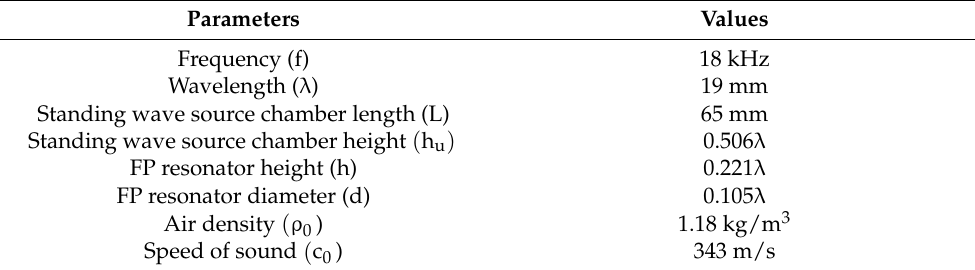
Figure 3. Optimized acoustic cavities for higher RMS pressure, P rms of ( a ) upper acoustic chamber height, h u , and ( b ) FP resonator height, h and diameter, d. Table 1. Acoustical and model parameters of the